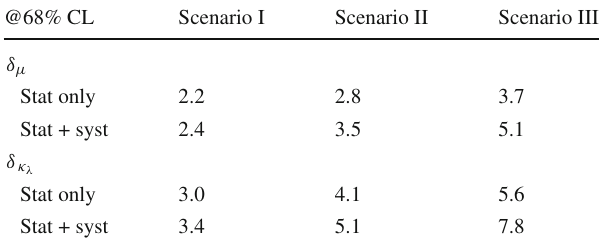
Table 7 Combined expected precision at 68% CL on the di-Higgs pro- duction cross- and Higgs self coupling using all channels at the